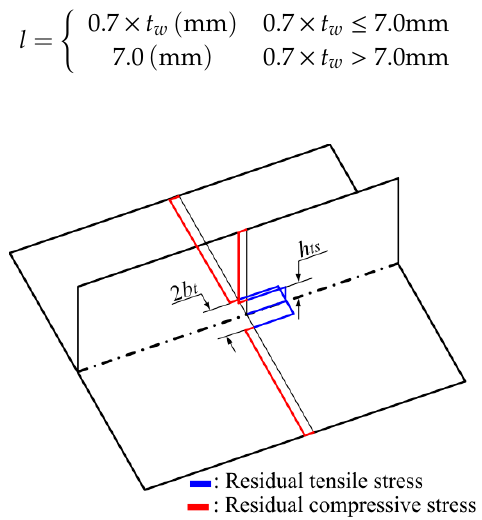
Figure 4. Assumed residual stress distribution in the fillet weld.